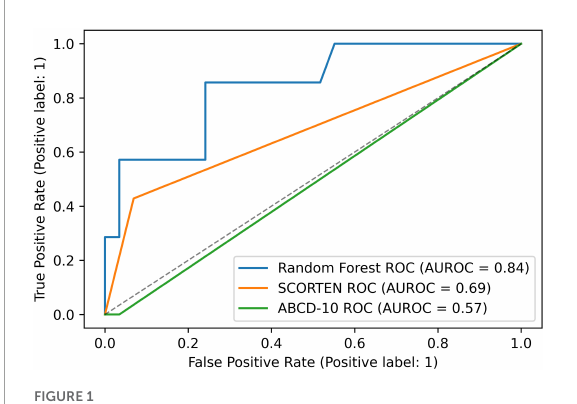
FIGURE1 A graph depicting receiver operating characteristic (ROC) curves for random forest, SCORTEN, and ABCD-10 scoring systems.